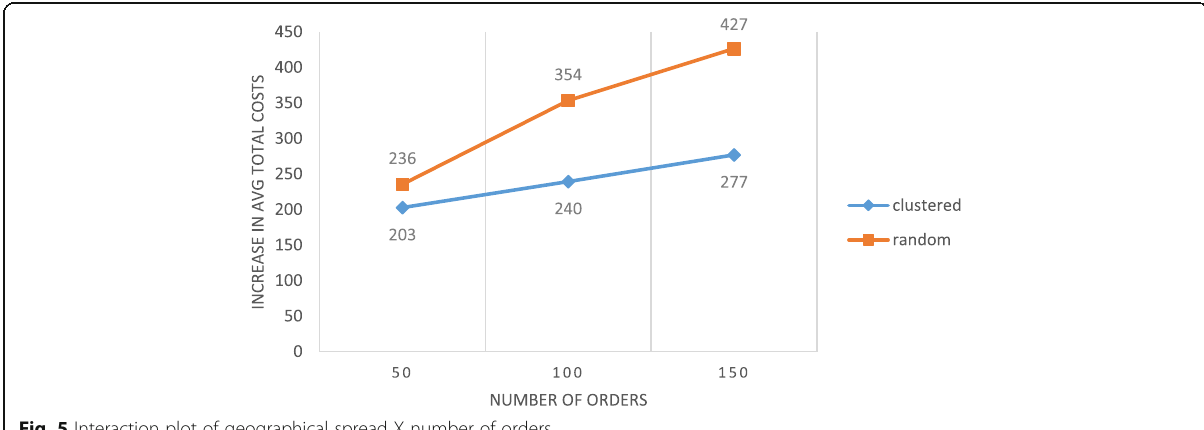
Fig. 5 Interaction plot of geographical spread X number of